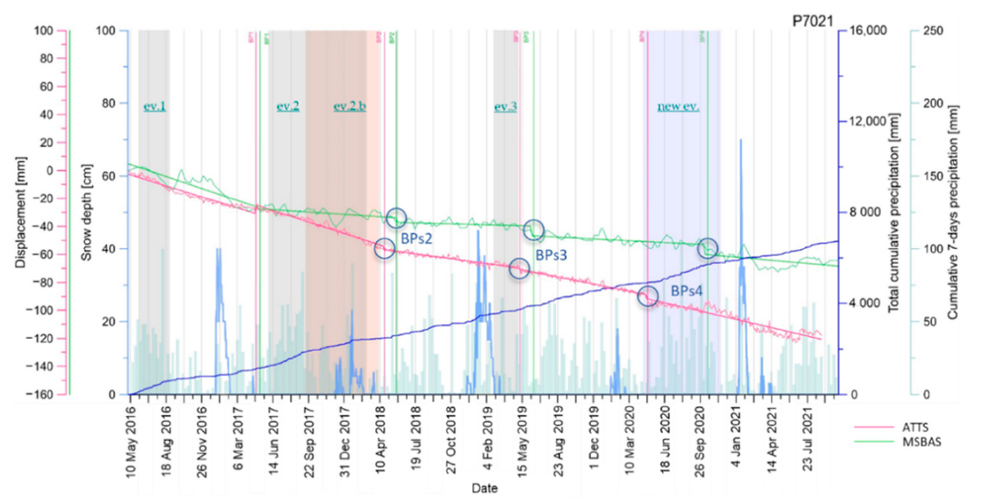
Figure 9. Vertical displacement time series correlation of ATTS (red) against MSBAS (green) for slab A. Evaluation of Trends and BPs of point n. P7021 plotted against total cumulative precipitation (dark blue line), cumulative 7-days precipitation (histogram), and snow depth (light blue line).